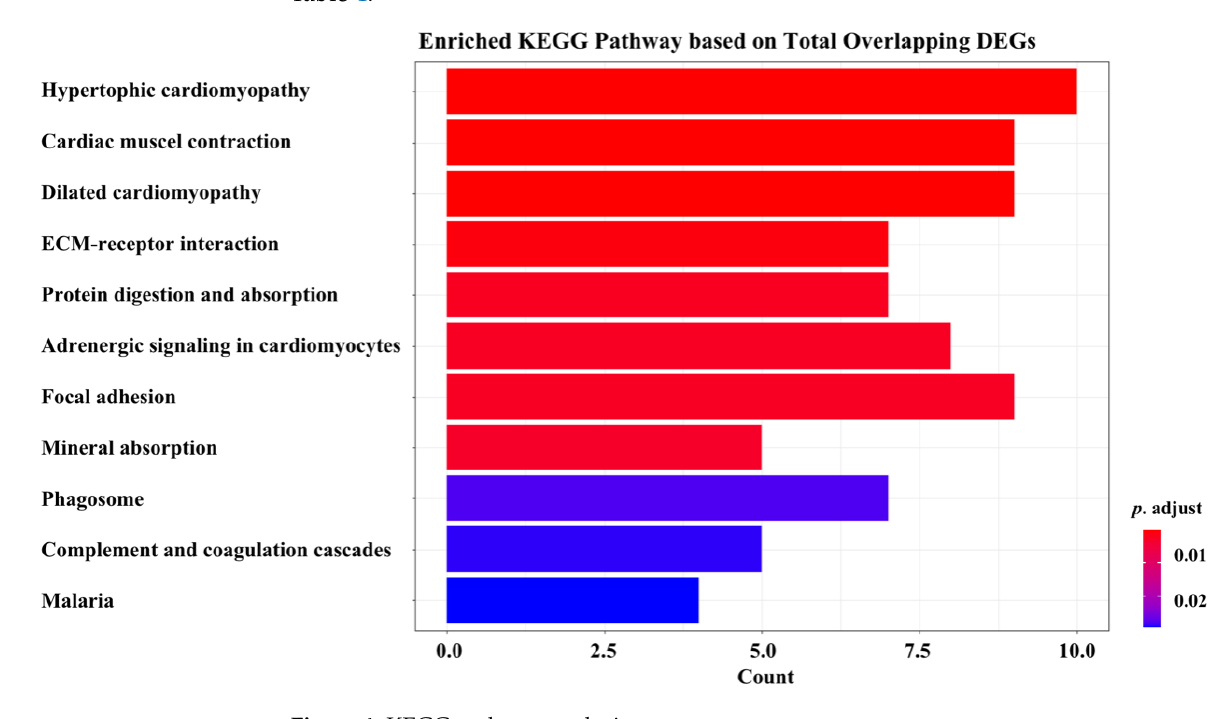
Figure 4. KEGG pathway analysis. Table 4. Enriched pathway and corresponding genes.